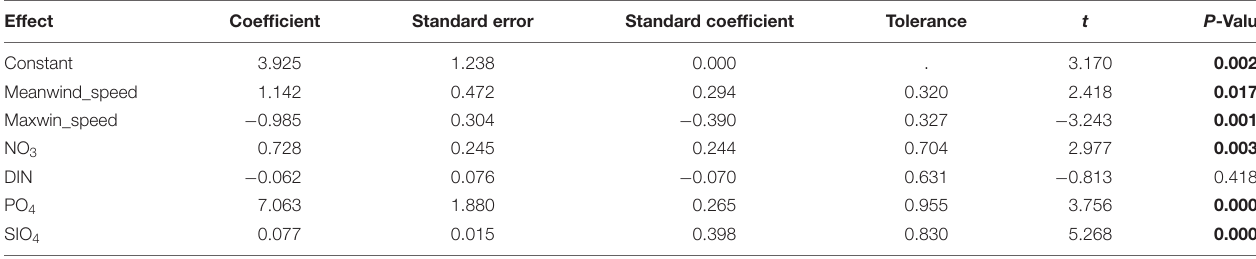
TABLE 6 | Results of the multiple regression analyses with forward selection of variables performed on the campaigns’ matrix to explain Chl a concentration in the water column in the Mar Menor lagoon during the last 22 years (1997–2018), using meteorological, hydrographical, and nutrients as independent variables. Effect